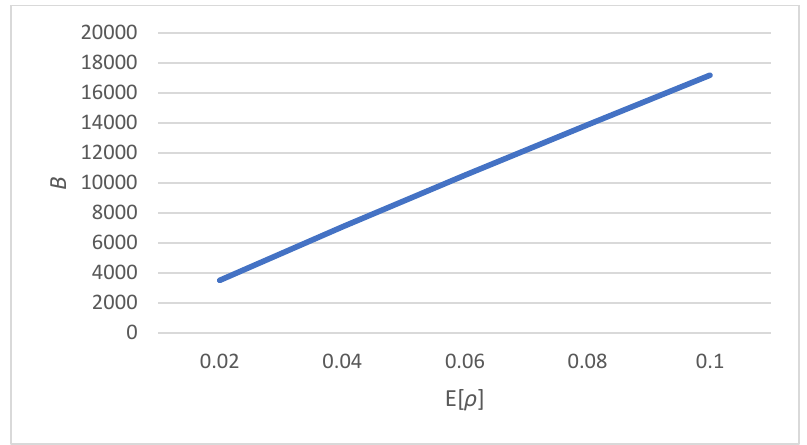
Figure 5. Effect of fraction of defective items ( 𝐸[𝜌] ) on backorder quantity ( 𝐵 ∗